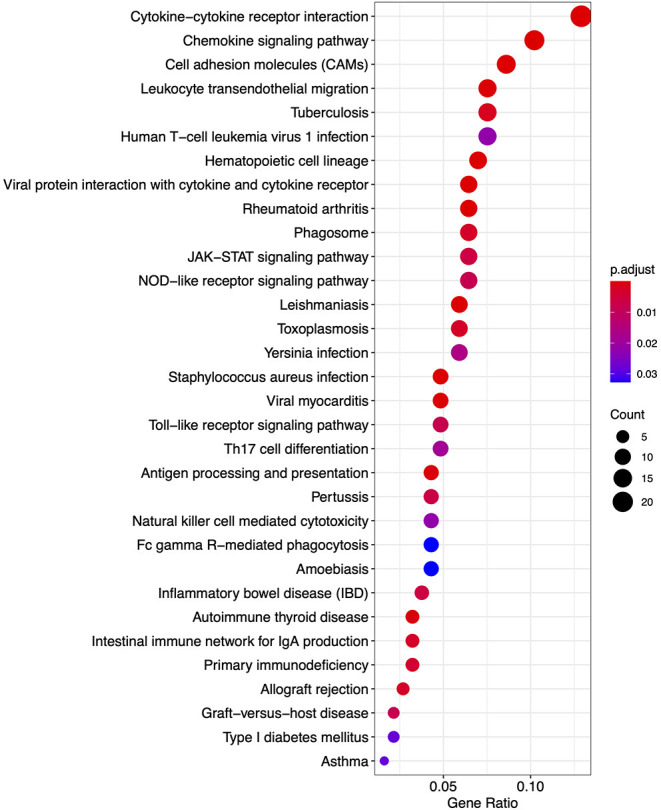
A dot plot of nominally significant KEGG pathways enriched among differentially expressed genes in FP. The x-axis shows the ratio of differentially expressed genes in each term relative to the total number of genes in that term. Dot size shows the number of differentially expressed genes in that term and color is the gene set enrichment analysis test statistic with Benjamini–Hochberg adjustment for multiple testing.